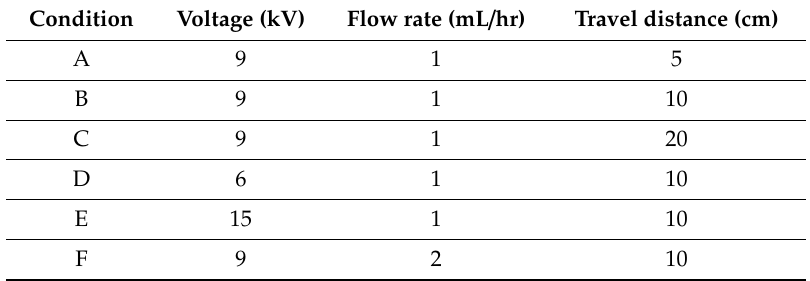
Table 1. Parameters used in the preliminary electrospraying protocols for microparticles production. Condition Voltage (kV) Flow rate (mL / hr) Travel distance